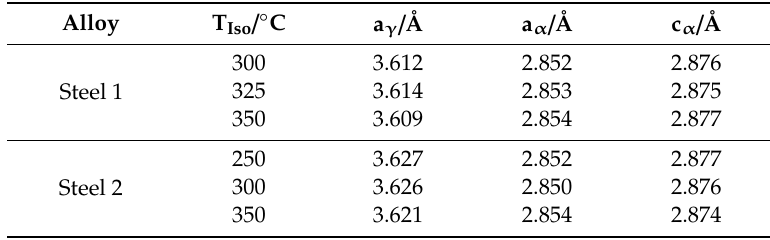
Table 2. Lattice parameters for austenite (a γ ) and bainitic ferrite (a α and c α ) obtained from XRD